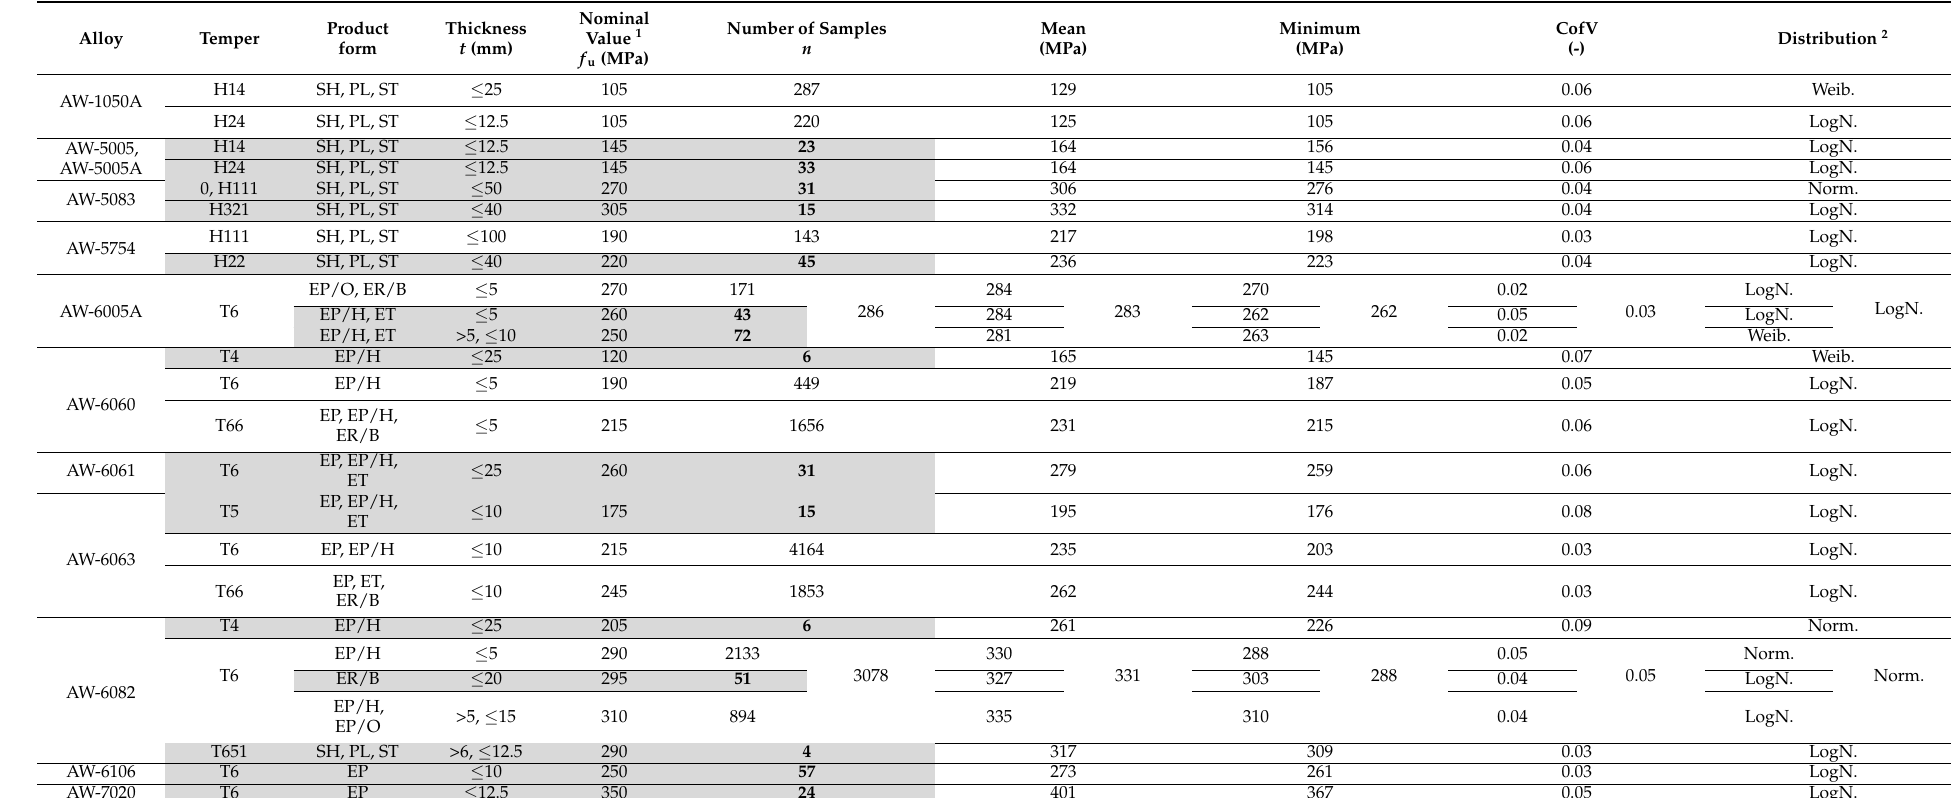
Table 4. Statistical analysis of ultimate tensile